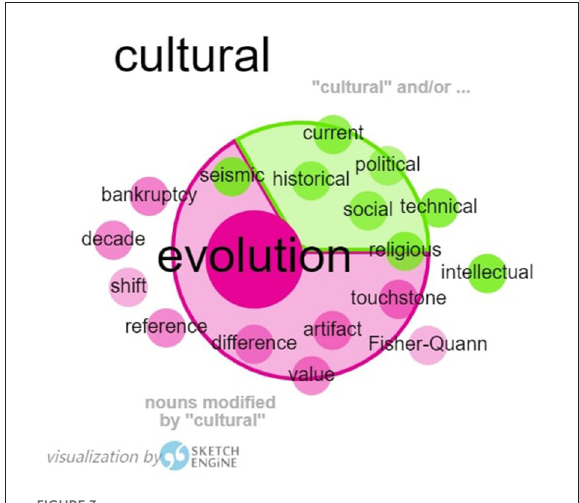
FIGURE3 Word sketch of “cultural” in the English subcorpus.